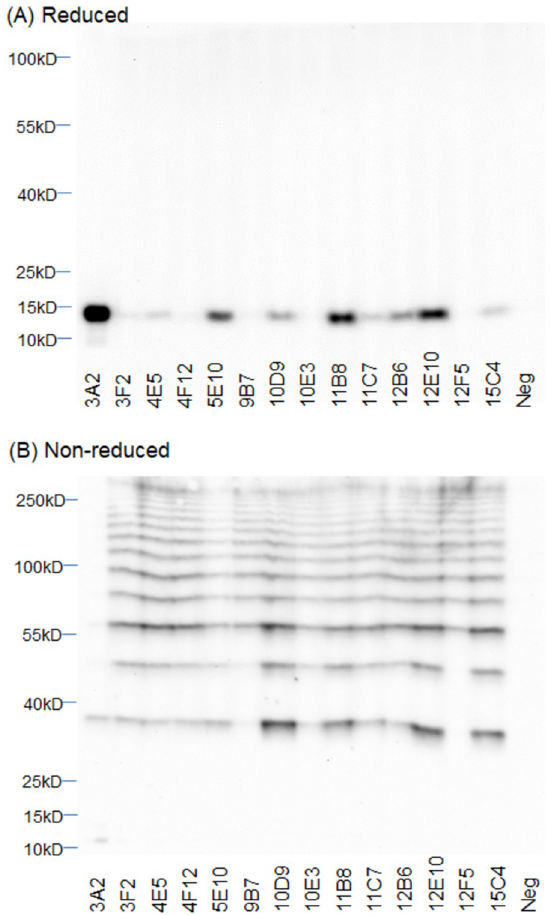
Fig 2. Western blot analysis of anti-F1 monoclonal antibodies (mAbs) against Yersinia pestis Harbin-35 lysate. Anti-F1 mAbs (1 μ g/mL) were used to probe (A) reduced and (B) non-reduced Y . pestis Harbin-35 bacterial lysate (1.5x10 6 cells/lane) by indirect Western blot. HRP-conjugated goat anti-mouse Ig was used for detection of F1 mAb binding.